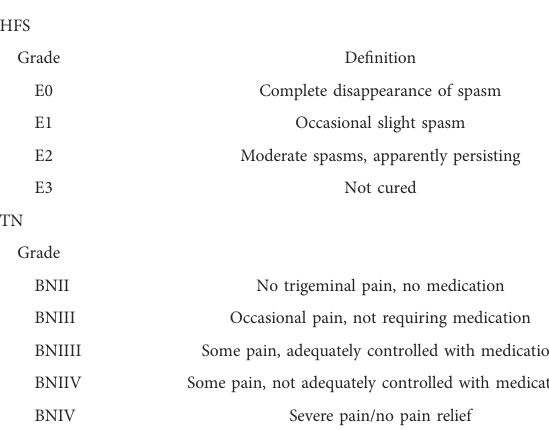
TABLE 2 Evaluation of HFS and